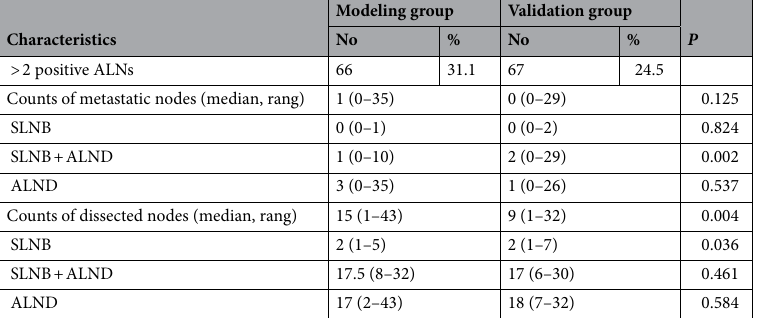
Modeling group Validation